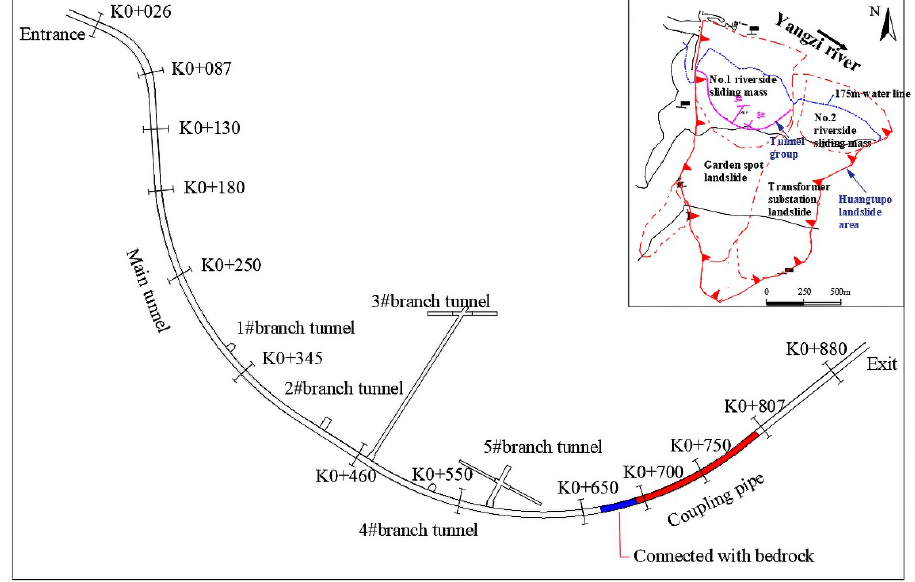
Figure 13. Tunnel group and the position of coupling pipe.